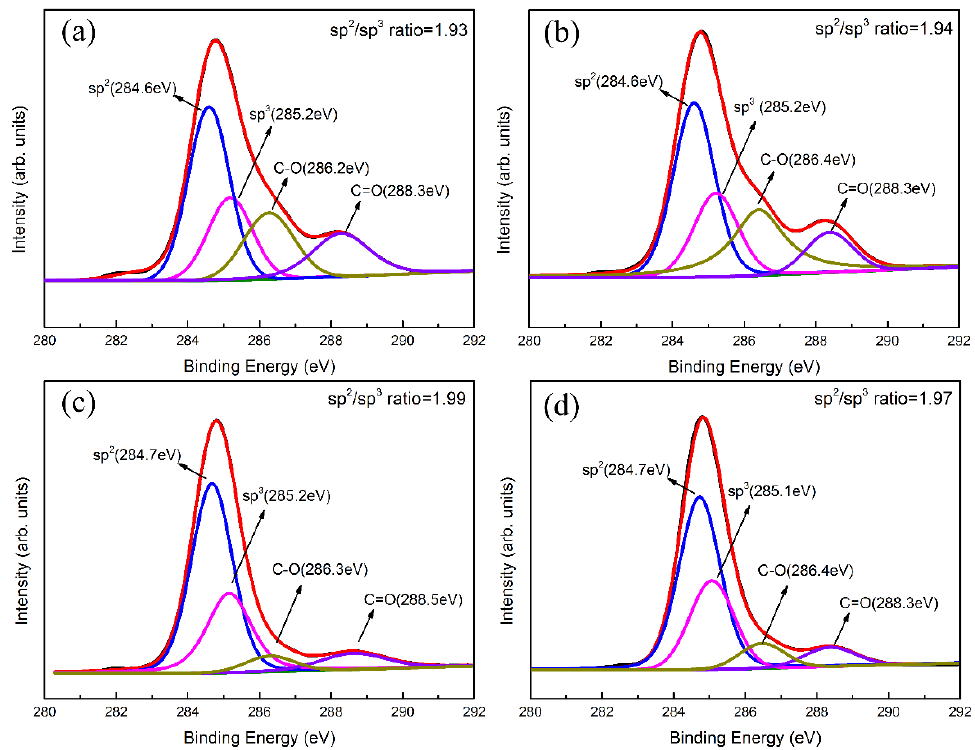
Figure 7. C1s XPS spectra fitting results and sp 2 /sp 3 ratio of Ti-DLC coatings with Ti transition layer thickness ( t 0 ): ( a ) 0 µ m, ( b ) 0.5 µ m, ( c ) 1.1 µ m and ( d ) 2.8 µ m.